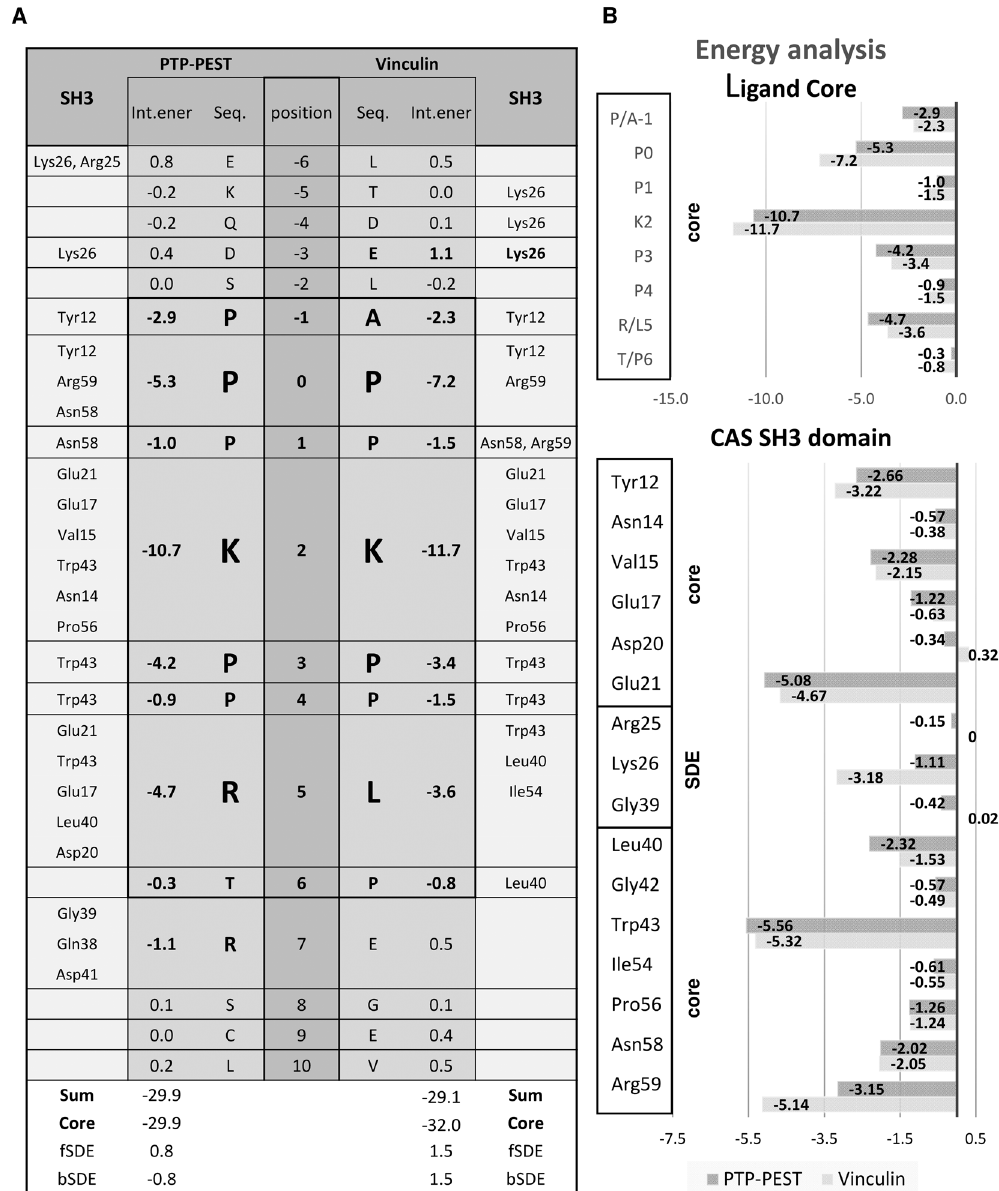
Figure 6. The attractive MM-GBSA energy contributions of individual protein and peptide residues toward binding (in kcal/mol). ( A ) Energy contribution of binding sequences of PTP-PEST or Vinculin to the CAS SH3 domain in fragmented CAS SH3 domain NMR structures. The peptide binding core is highlighted (-1 to 6). ( B ) Upper graph shows the CAS SH3 domain ligand-core binding energy contributions. Lower graph shows the energy contributions of CAS SH3 amino acid residues to binding Vinculin or PTP-PEST. fSDE: N-terminal SDE; bSDE: C-terminal